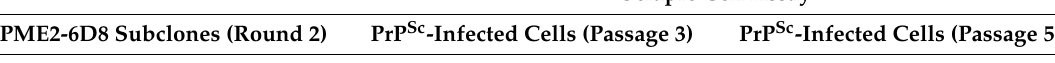
Table 2. Cont . Scrapie Cell Assay